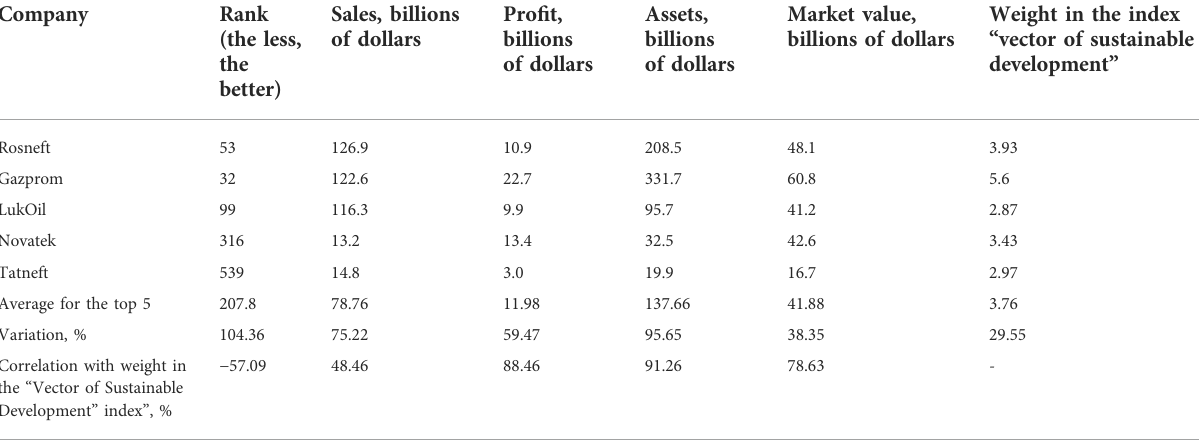
TABLE 1 Financial indicators and weight in the index “ Vector of sustainable development ” of the top fi ve Russian oil and gas companies in 2022. Company Rank